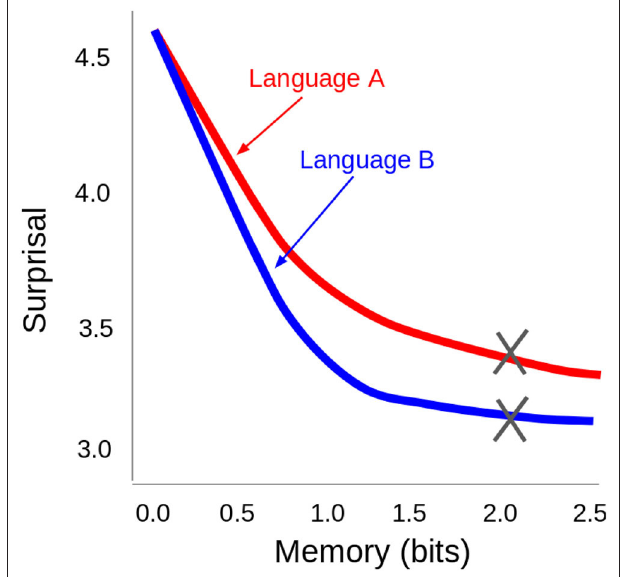
FIGURE 1 | Example memory–surprisal trade-off curves for two possible languages, A and B . While storing 2.0 bits in memory in language A , it is possible to achieve an average surprisal of around 3.5 bits; but in language B , a lower average surprisal can be achieved at the same level of memory usage. Language B has a steeper memory–surprisal trade-off than Language A , so it requires less memory resources to achieve the same level of surprisal. Figure from Hahn et al.